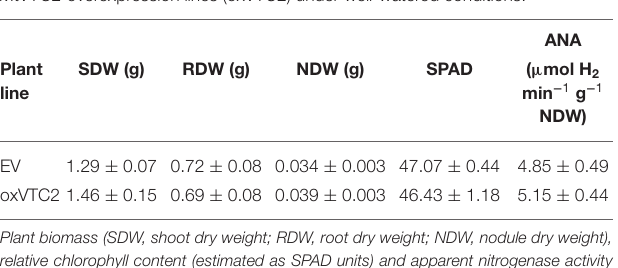
TABLE 2 | Physiological characterization of M. truncatula empty vector (EV) and MtVTC2 overexpression lines (oxVTC2) under well-watered conditions.